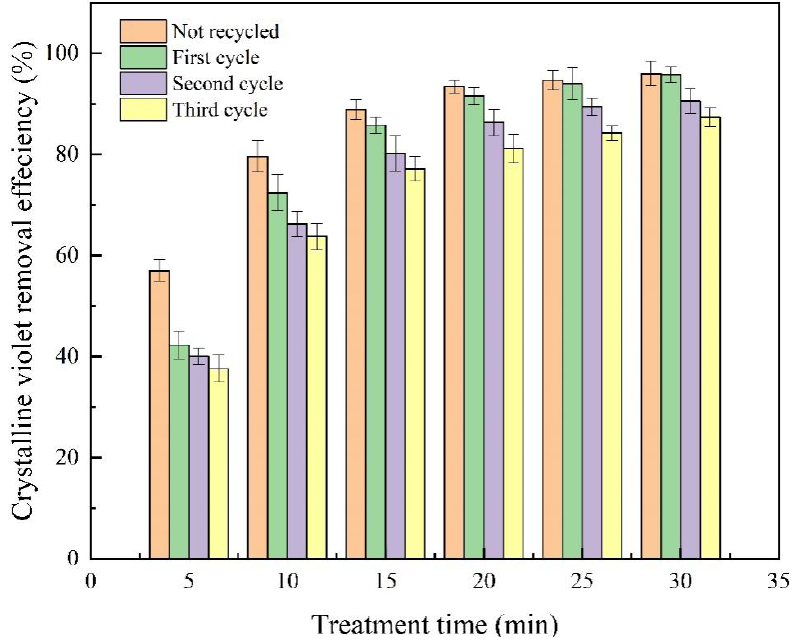
Table 1. Fe and Al content in the solution at the end of the reaction.